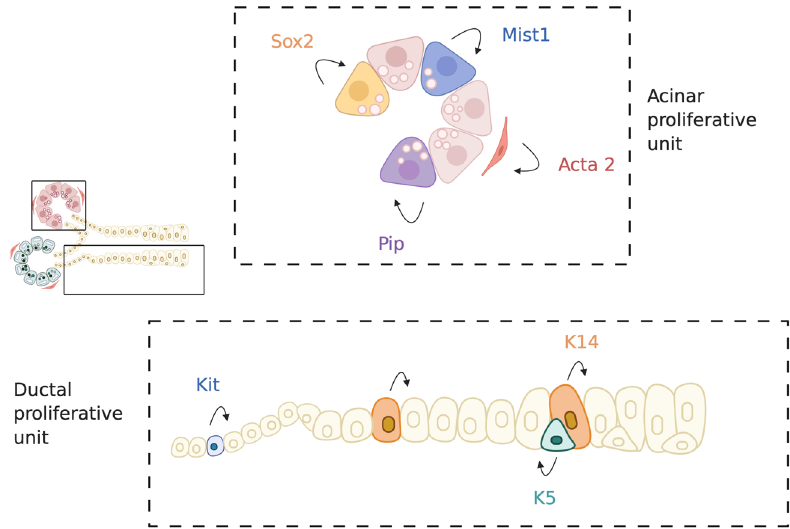
Fig. 2 Salivary gland homeostasis seems to be achieved via self-duplication of lineage-restricted progenitor cells. Salivary glands are suggested to be structured in salivary gland proliferative units (SPUs), respectively, the acinar and the ductal proliferative units. Each unit contains multiple lineage-restricted progenitor cells, which, under normal homeostatic conditions, are able to self-duplicate and replace the lost cells within the unit (Figure created with